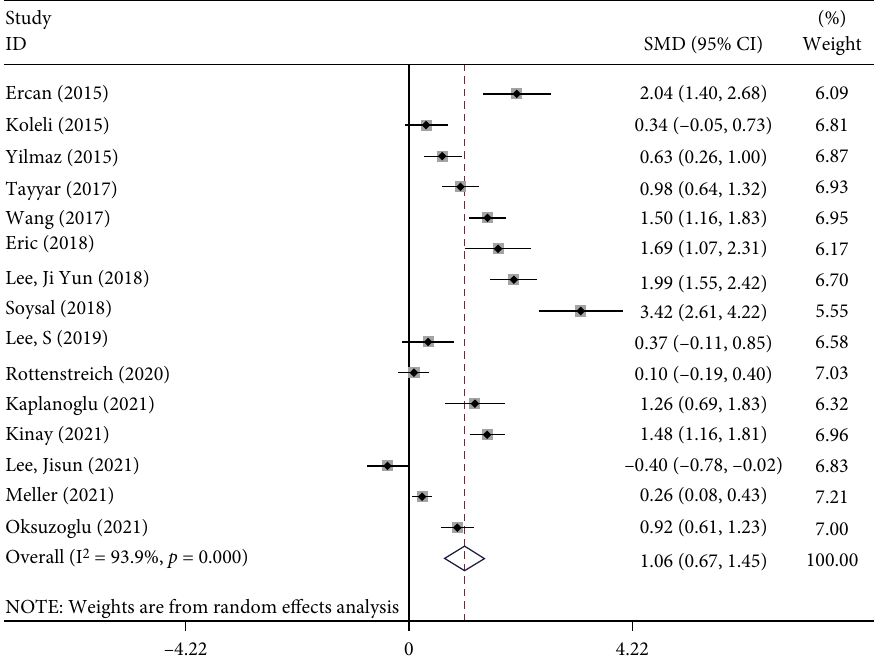
Figure 2: Meta-analysis of di ff erences in NLR level between patients with AT compared to patients who were operated due to adnexal mass and reported as having a benign ovarian cyst, without torsion.